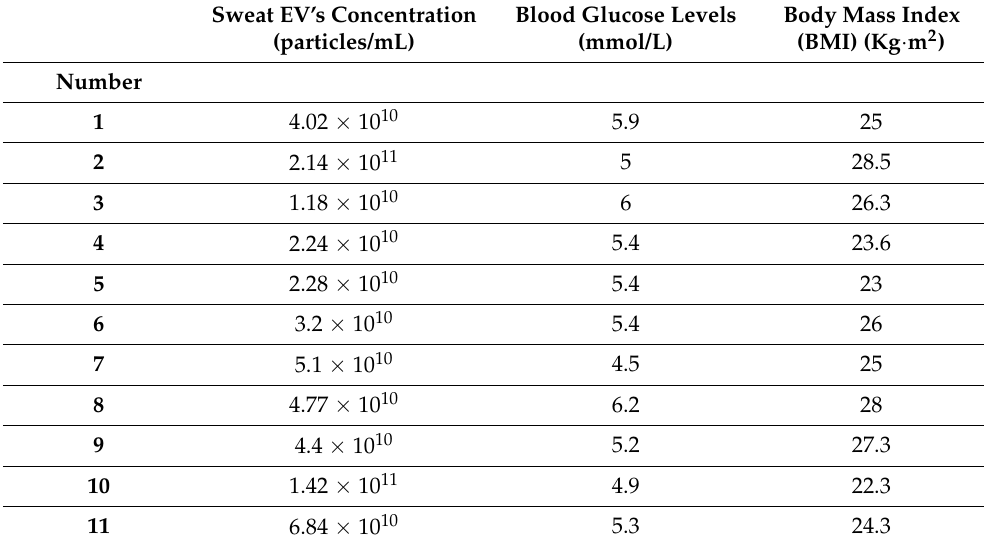
Table 2. Concentration of sweat EVs (particles/mL), blood glucose (BG) levels, and body mass index (BMI) of each participant. n = 11 healthy control